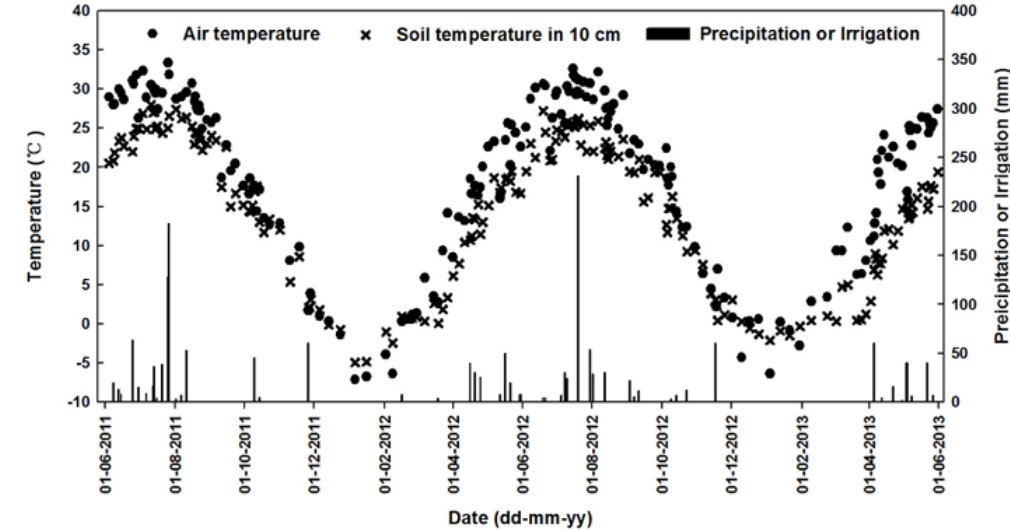
Fig. 1. Air temperature, soil temperature at 10cm depth, and precipitation or irrigation in the winter wheat–summer maize double-cropping system from June 2011 to June